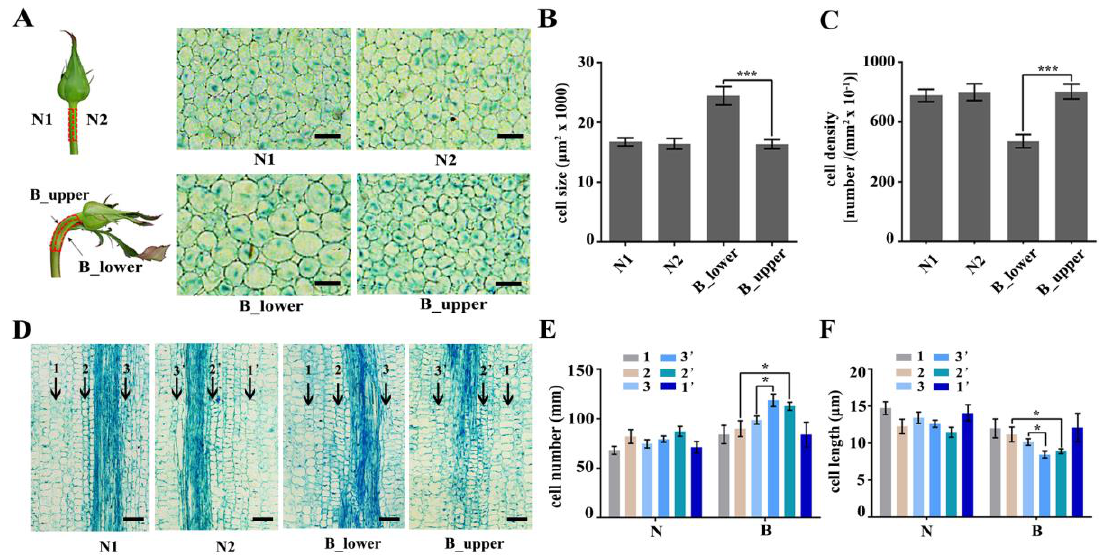
Figure 2. The cellular structure of BP. ( A – C ) Transverse sections of the two sides ( A ) and their respective cell size ( B ) and cell numbers ( C ) in NP and BP. ( D – F ) Longitudinal sections of the two sides ( D ) and their respective cell numbers ( E ) and cell lengths ( F ) in NP and BP. 1 and 1’ refer to parenchyma cells from the two sides, 2 and 2’ refer to primary phloem cells from the two sides, and 3 and 3’ refer to primary xylem cells from the two sides. Scale bars = 100 µm. Error bars represent SD. Three biological replicates were used. Asterisks denote statistically significant differences determined by using Student’s t -test (* p < 0.05, *** p < 0.001).